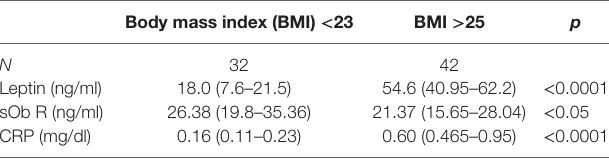
TaBle 2 | Serum levels of leptin, soluble leptin receptor (sOb R), and C-reactive protein (CRP) in lean and obese